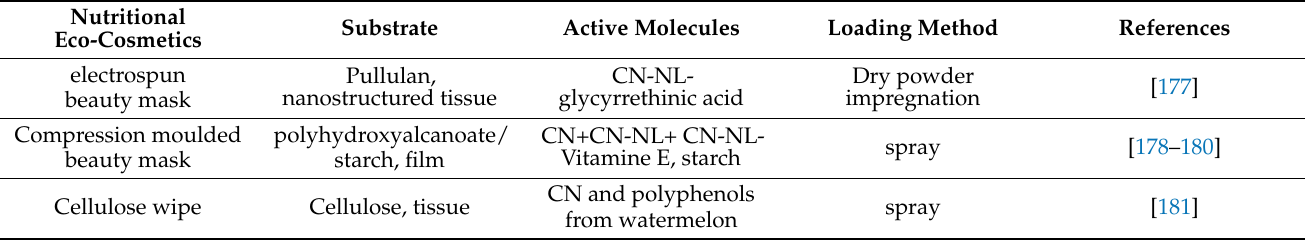
Table 2. List of three different nutritional